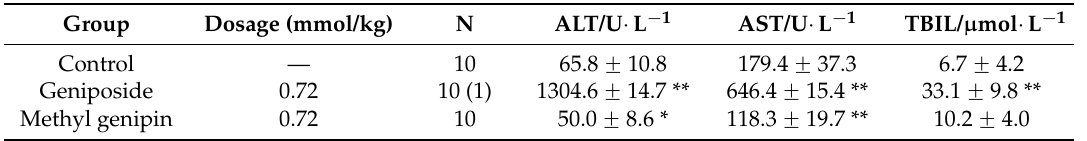
Table 2. Effects of GE or MG on biochemical parameters in blood of rats. ALT: alanine aminotransferase; AST: aspirate aminotransferase; TBIL: total bilirubin.